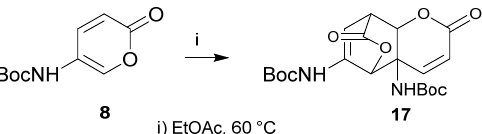
Table 1. Results from cyloadditions of 5-(BocNH)-2(H)pyran-2-one, 8, with various dienophiles. Dienophile Cycloadduct